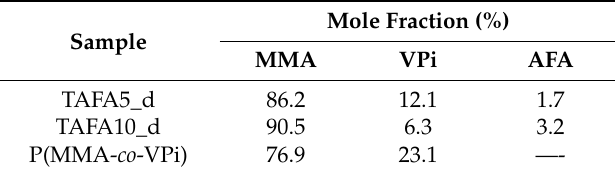
Table 4. Polymer composition obtained by 1 H-NMR.